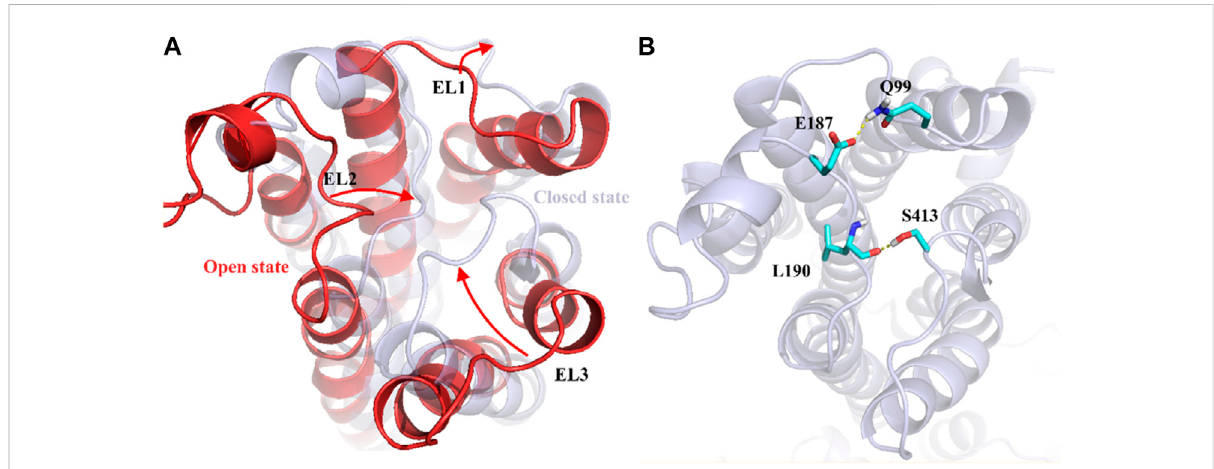
FIGURE 5 DemonstrationofEls ’ sroleinthemechanismofTAbindingobtainedfromFMsimulation. (A) Transformationoftheproteinfromtheopentothe closedstate,involvingEL1,El2,andEL3.ThecorrespondingmovementofeachELisdepictedasredarrows (B) Theeffectivehydrogenbondbetween residues Glu187 and Gln 99 and also between Leu190 and Ser413, holds EL2 and EL3 together in the closed state.